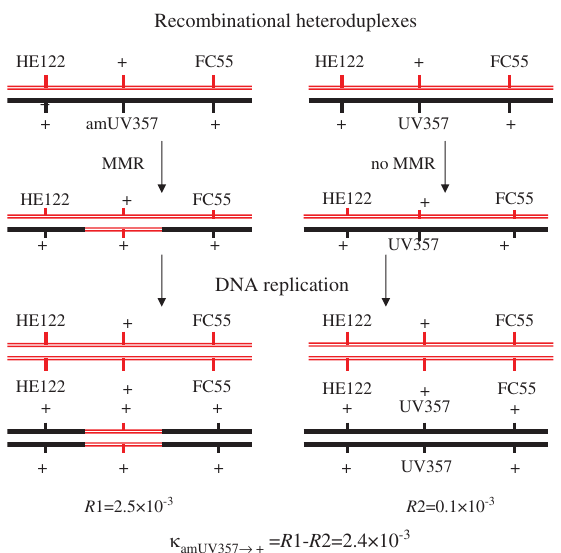
Figure 4 A way to estimate MMR contribution ( κ ) to the recom- binant frequency ( R ) in homoallelic three-factor crosses HE122 FC55 × amUV357 and HE122 FC55 × UV357. Heteroduplex intermediates and their repair and replication are = R 1- R 2 = 2.4 × 10 -3 (46) . shown. Repairability κ amUV357 → +